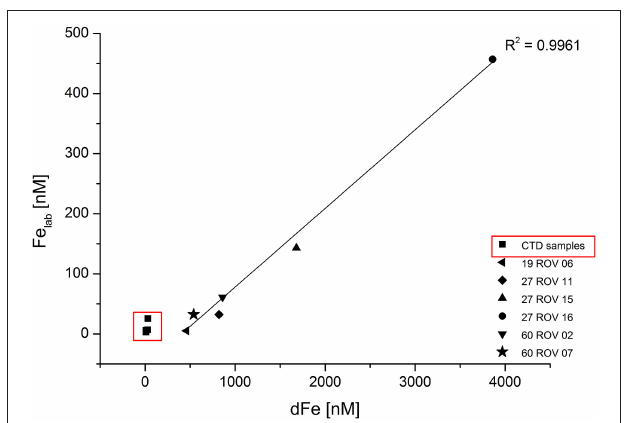
FIGURE 5 | Labile Fe (Fe lab ) plotted against dissolved Fe (dFe) for all ROV samples collected within the buoyant plume and CTD samples (within red square) collected within the non-buoyant plume.